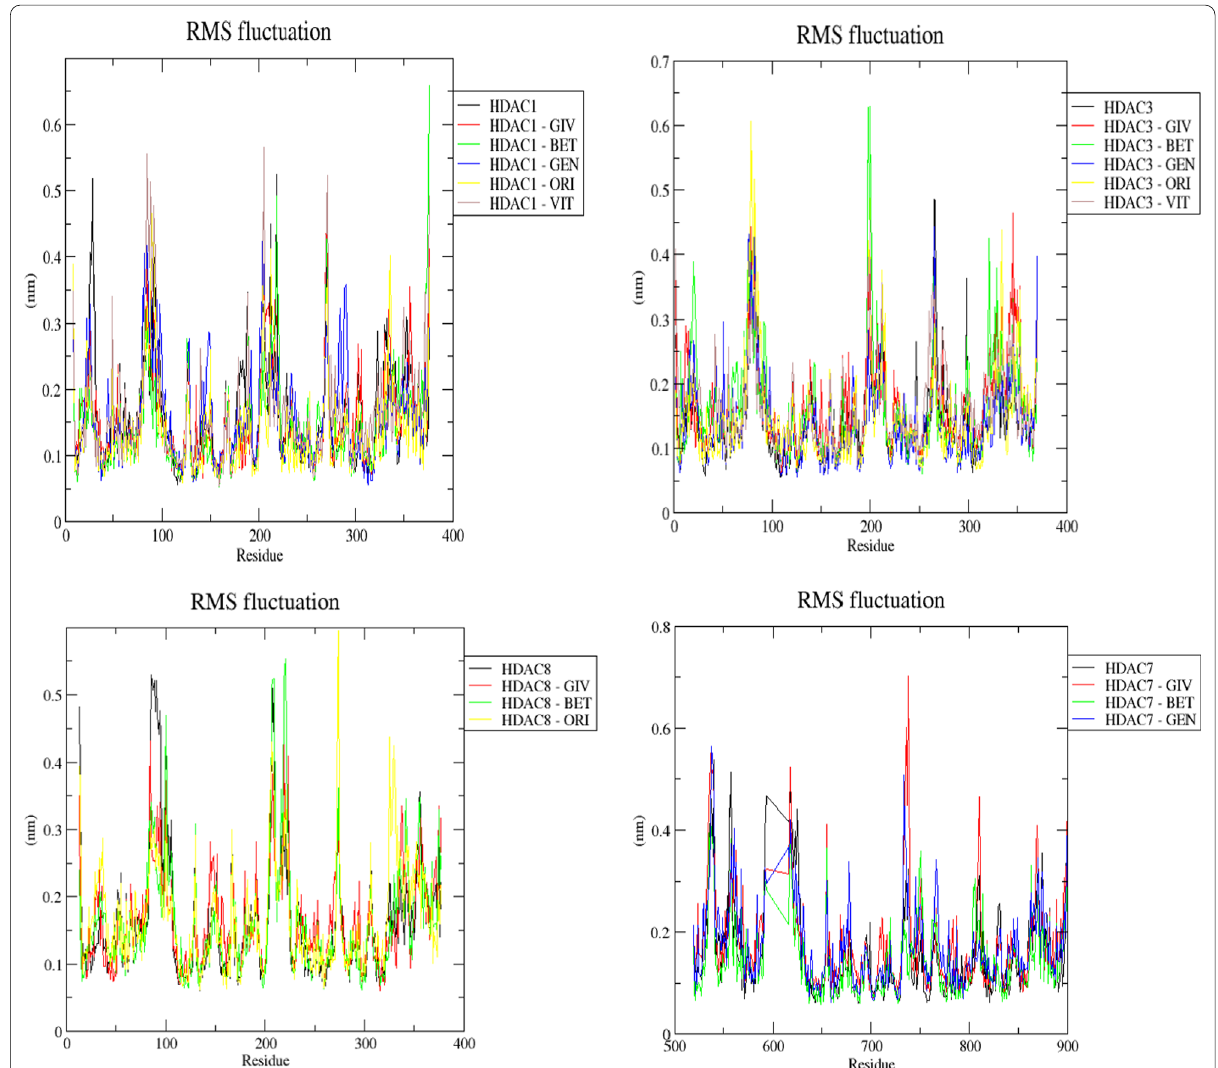
Fig. 10 The graphs reflecting the RMSF values of C-alpha atoms for HDAC1, HDAC3, HDAC8 and HDAC7